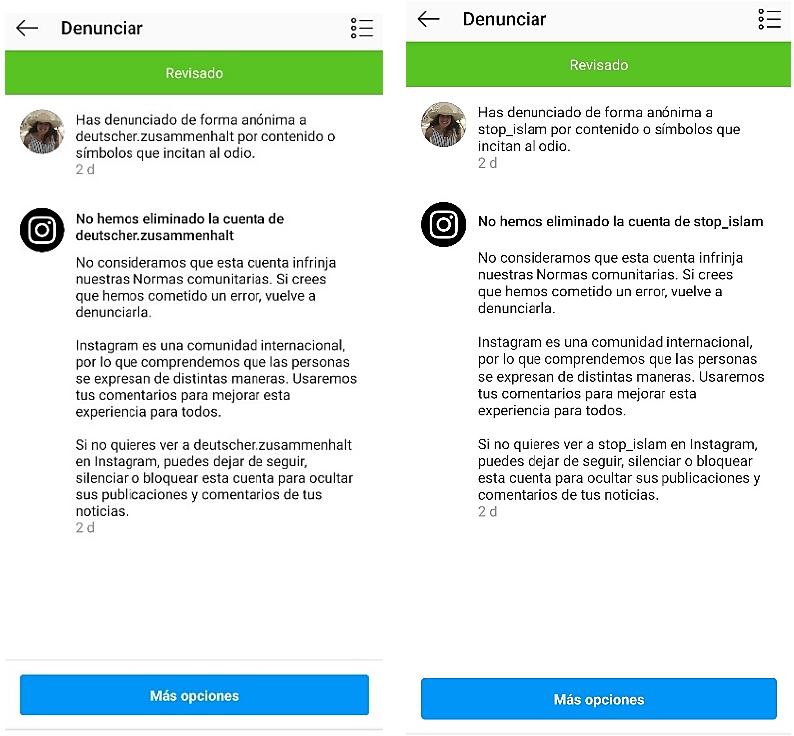
Figure 3. Examples of Instagram’s institutional response to Islamophobia complaints. Caption: We do